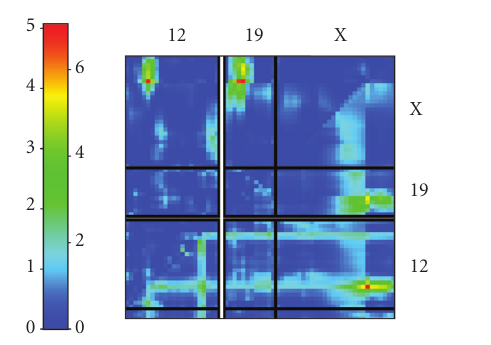
Figure 5. Multiple QTL mapping analysis. In the upper left tri- angle, a pseudo-color plot shows the likelihood ratio statistic for each two-locus interaction. In the lower right triangle, a like- lihood ratio statistic is depicted for the full two-locus model, which fits additive e ff ects for each pair of loci and their inter- action. Significance was assessed by genome-wide permutation